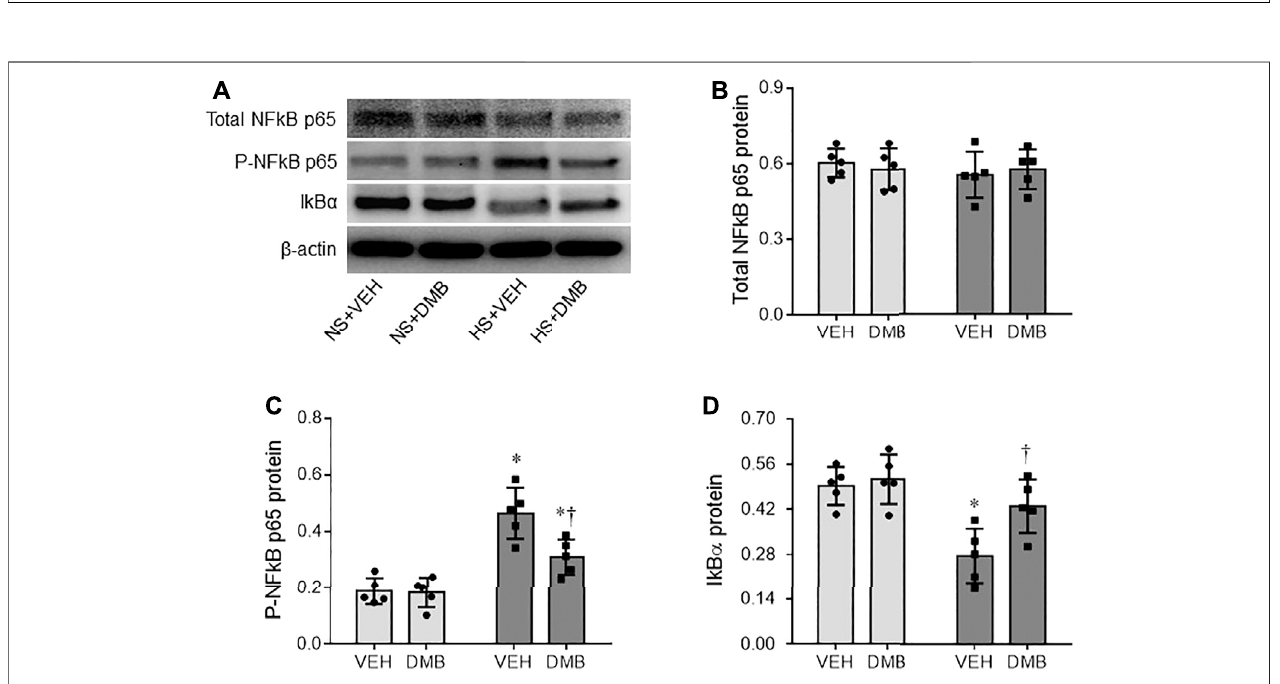
FIGURE 4 | Representative Western blots (A) and quantitative comparison for protein levels of total NF- κ B p65 (B) , phosphorylated (p)-NF- κ B p65 (C) and NF kappa B inhibitor(I κ B)- α (D) in the PVN in rats fed a normal salt (NS) diet or a high salt (HS) diet and simultaneously treated with vehicle (VEH) or 1.0% 3,3-Dimethyl-1- butanol(DMB,an inhibitor of trimethylamine formation). All data are expressed asmean ± SEM ( n = 5 rats/per group). p p < 0.05 vs . NS+ VEH; † p < 0.05, HS+ DMB vs . HS + VEH.